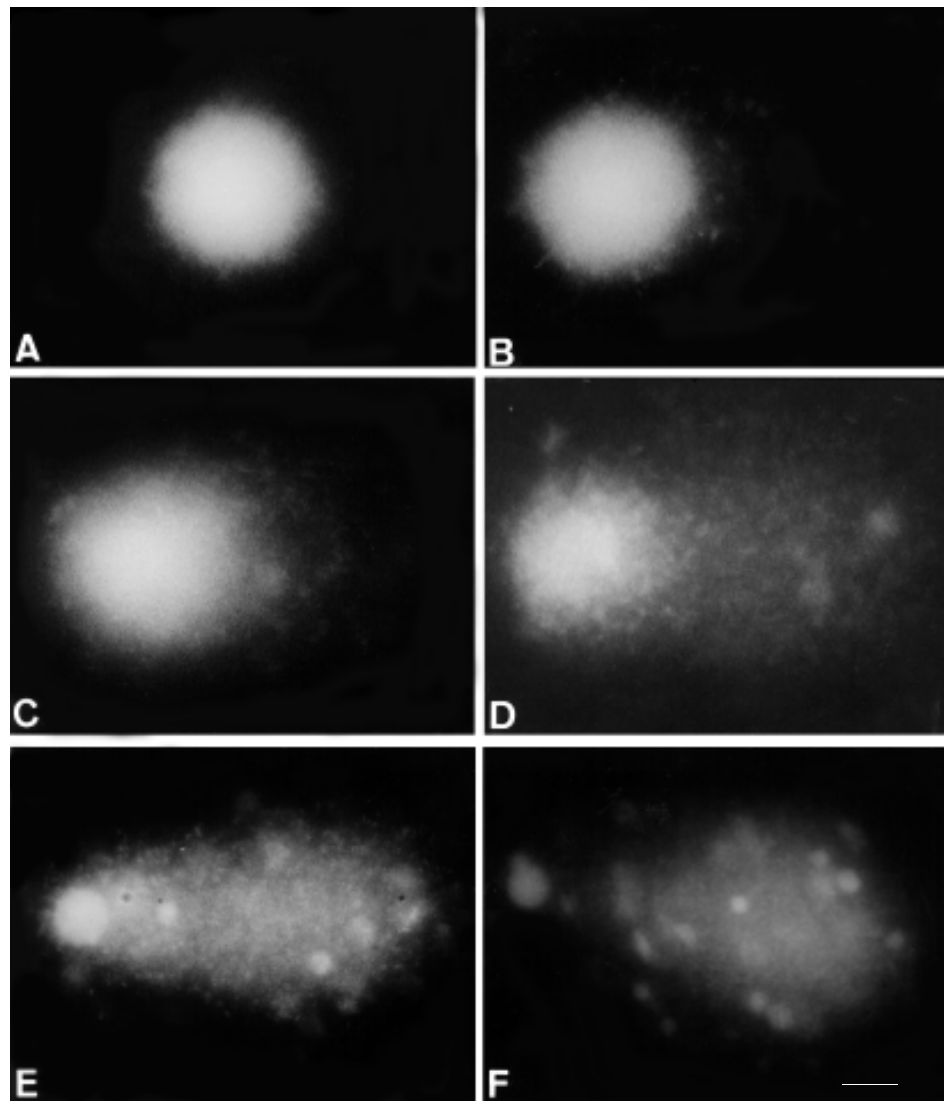
Figure 1 - Photomicrographs showing the classification of Ctenomys torquatus blood cells in the comet assay. A , Class 0, undamaged; B , class 1; C , class 2; D , class 3; E , class 4, maximum damage; F , apoptotic cell. Bar = 10 m m.